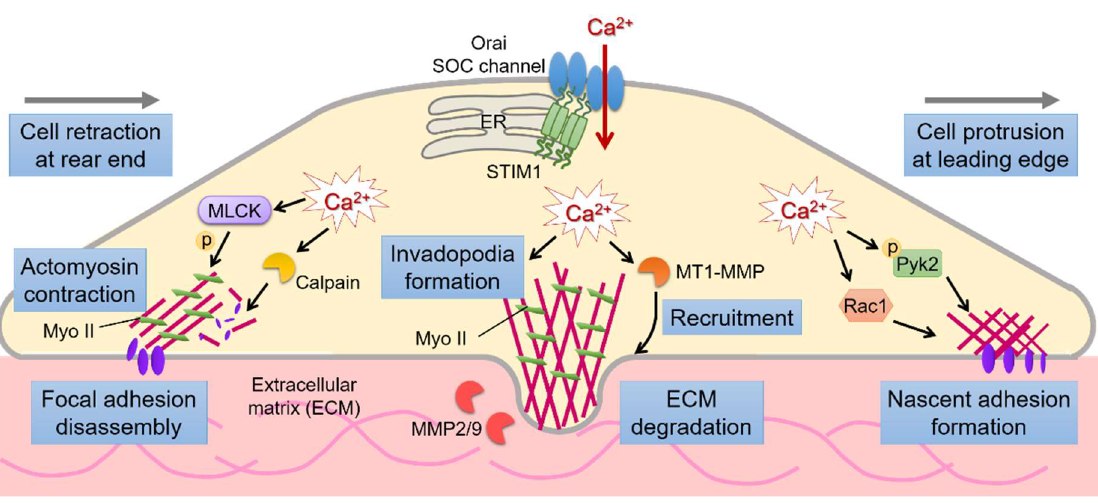
Figure 1. STIM1-mediated Ca 2+ influx regulate the invasive migration of cancer cells through focal adhesion turnover, actomyosin contractility, and invadopodia formation. STIM1-dependent Ca 2+ signaling integrates the dynamic interactions between actomyosin contraction and focal adhesion turnover to mediate efficient cell migration. STIM1-dependent Ca 2+ signals also promote cancer cell invasion through the formation and maintenance of the invadopodia structures and the activation and incorporation of proteolytic enzymes like MMPs and MT1-MMP.